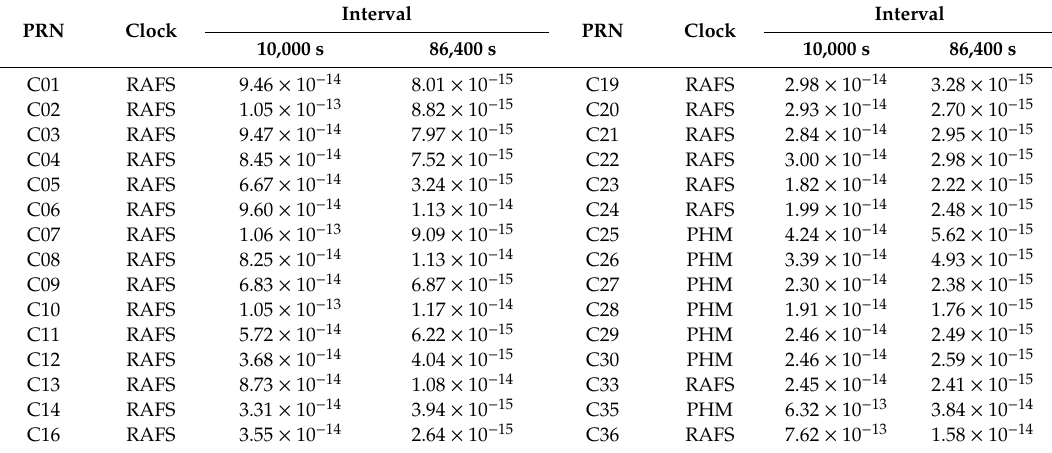
Table 9. The frequency stability of the BD3 satellites at intervals of 10000 s and 86400 s.